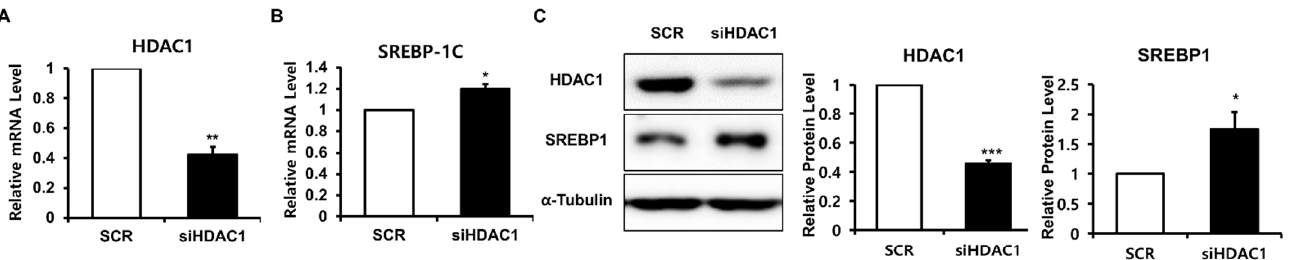
Figure 4. Histone deacetylase 1 (HDAC1) knockdown induced sterol regulatory element binding protein 1c (SREBP-1c) expression and lipogenesis in SZ95 cells. SZ95 cells were transfected with 100 nM negative control scrambled siRNA (SCR) or HDAC1 siRNA (siHDAC1) for 6 h and the medium was replaced with 10% FBS. After 48 h, ( A , B ) HDAC1 and SREBP- 1c mRNA expression was measured using real-time PCR and ( C ) HDAC1 and SREBP1 protein expression was measured using Western blotting. α -Tubulin served as a loading control. ( D ) Histone H3 and H4 acetylation observed using Western blot analysis 48 h after HDAC1 knockdown. Histone H2A served as a loading control. ( E ) Lipid contents were visualized by Oil Red O staining, quantified using the Image J software (left), and eluted into isopropanol at 72 h. The optical density at 500 nm was determined using a microplate reader (right). Scale bar = 100 µm. ( F ) Triglyceride (TG) content analysis using a TG assay kit performed 72 h after HDAC1 knockdown. Data represent the mean ± SD of three independent exper- iments ( n = 3). * p < 0.05, ** p < 0.01, *** p < 0.001 vs. scramble siRNA-transfected control. To further assess whether decreased HDAC1 is necessary for insulin and LXR ago- nist-induced lipogenesis, we transfected SZ95 cells treated with insulin and the LXR ago- nist with the HDAC1-pcDNA3 plasmid or pcDNA3-mock plasmid. Overexpression of HDAC1 significantly decreased the mRNA and protein levels of SREBP1 48 h after trans- fection (Figure 5A–C). Histone acetylation also decreased 24 h after HDAC1 overexpres- sion (Figure 5D). Furthermore, HDAC1 overexpression reduced lipid accumulation and the TG content in SZ95 cells at 72 h ( Figures 5E,F and S4). To further explore whether HDAC1 regulated SREBP1 transcription, we analyzed SREBP1 promoter activity 24 h af-